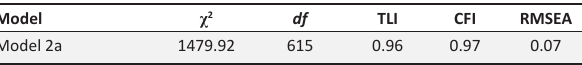
TABLE 3: Fit statistics of competing structural